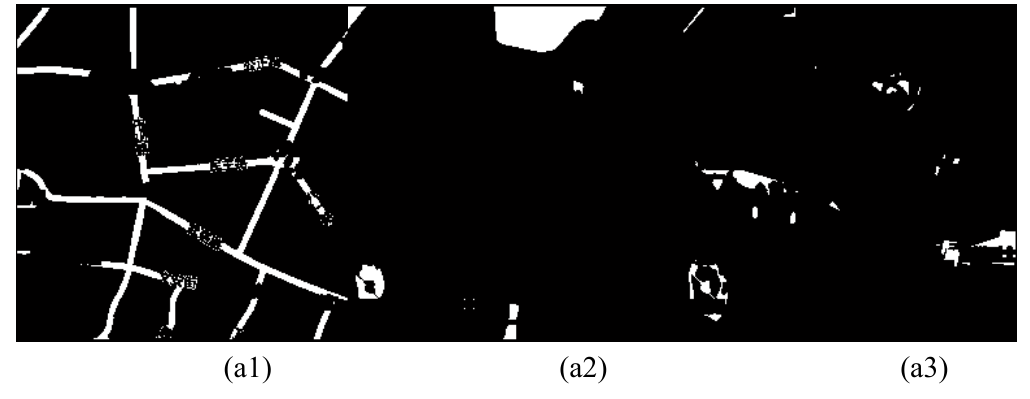
Figure 6. The manual segmentation result of Figure 3(a): (a1) the “road” of manual segmentation (a2) the “lake” of manual segmentation (a3) the “terrain” of manual